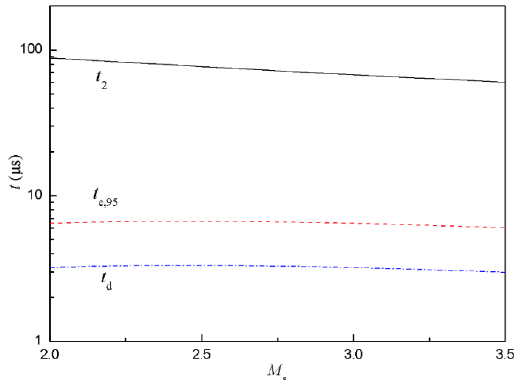
Figure 5. Characteristic time estimated for evaporation of droplets and diffusion at different Mach number of incident shock.